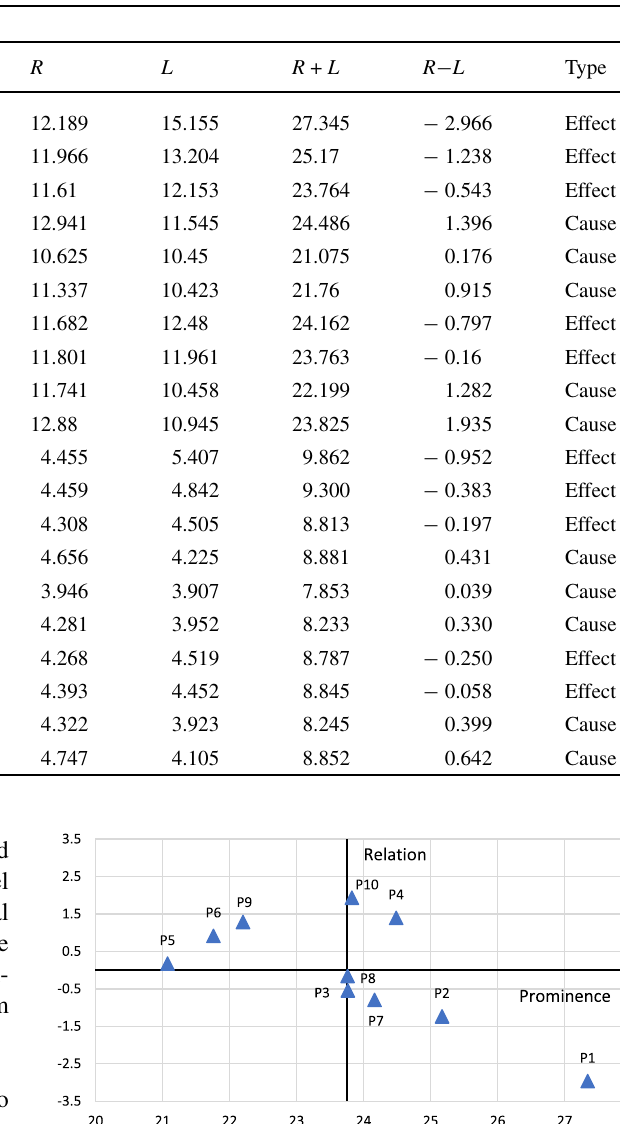
the Eqs. (8) and (9) as shown in Table 6. Step 5: Achieve the sums of row and column in the fuzzy total strength-influence matrix. Theoptimalweightcoefficientsaredeterminedbythetotal direct/indirect effects, while Eqs. (10) and (11) are used to 7 and Fig.